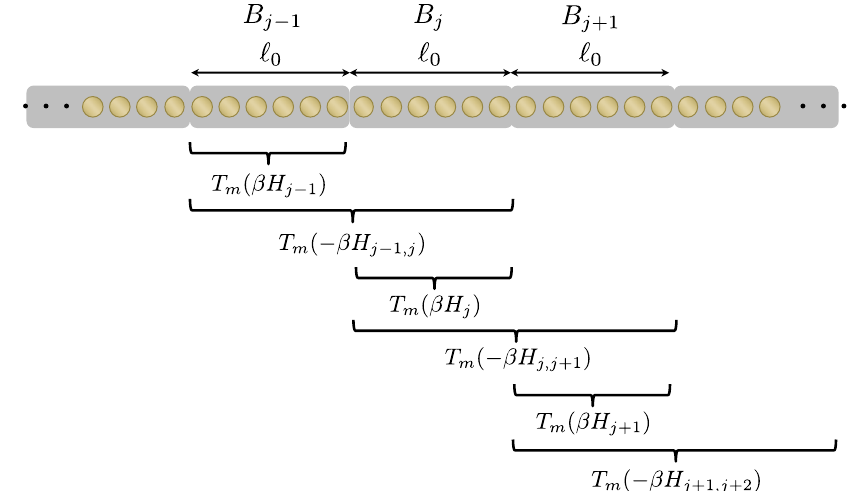
FIG. 8. Basic strategy for the approximation of e − β H [ β ≤ 1 = ð 8 gk Þ ]. We decompose the total systems into blocks. We then take the two-step approximation: (i) e − β H ≈